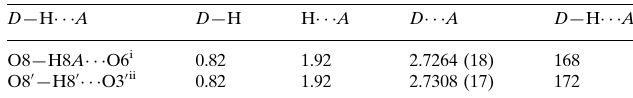
Hydrogen-bond geometry (A˚ , (cid:2)